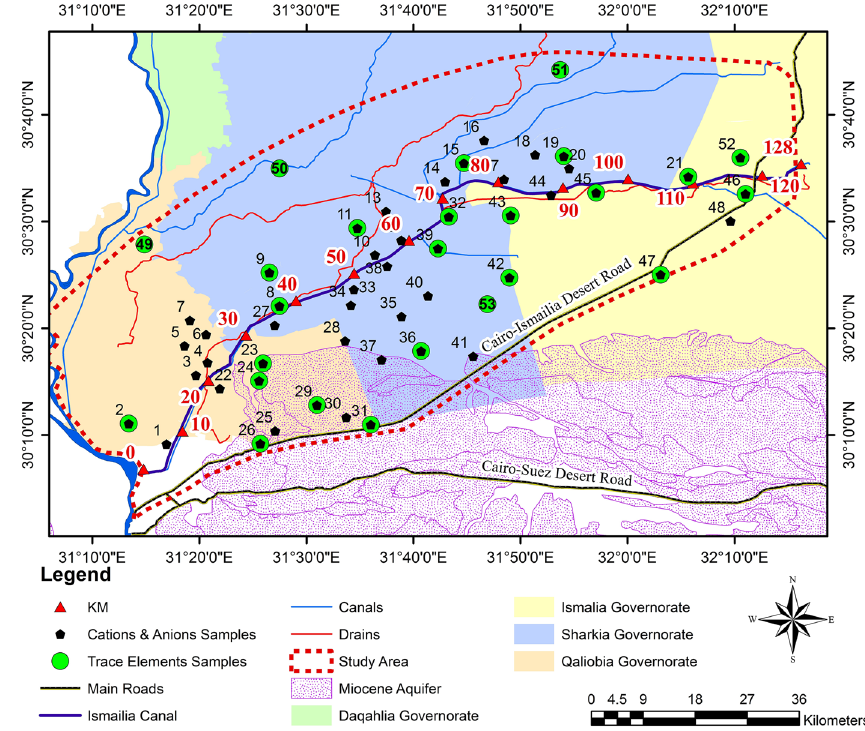
Fig. 1 Map of the study area and location of groundwater